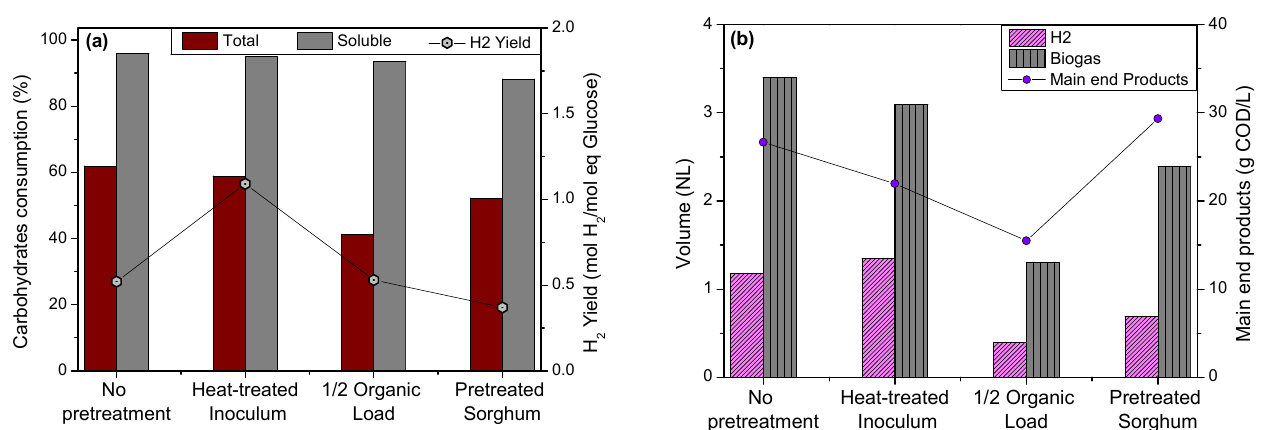
Figure 5. ( a ) Carbohydrates consumption and H 2 yield; ( b ) biogas, H 2 and soluble main end-products accumulation at pH 5.5 for all tested factors.